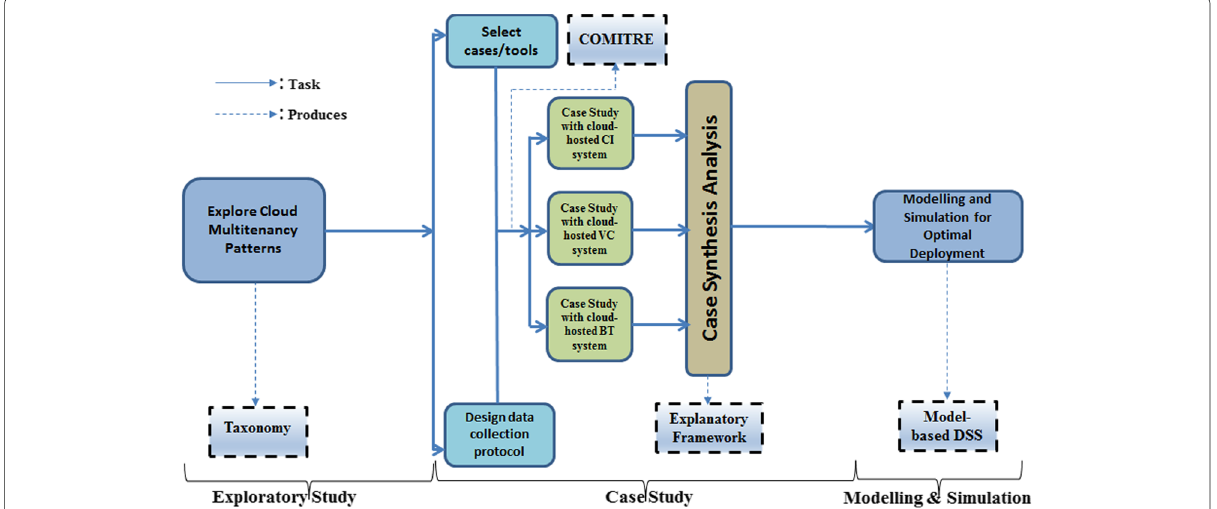
Fig. 3 Overall methodology for architecting the deployment of cloud-hosted services for guaranteeing multitenancy